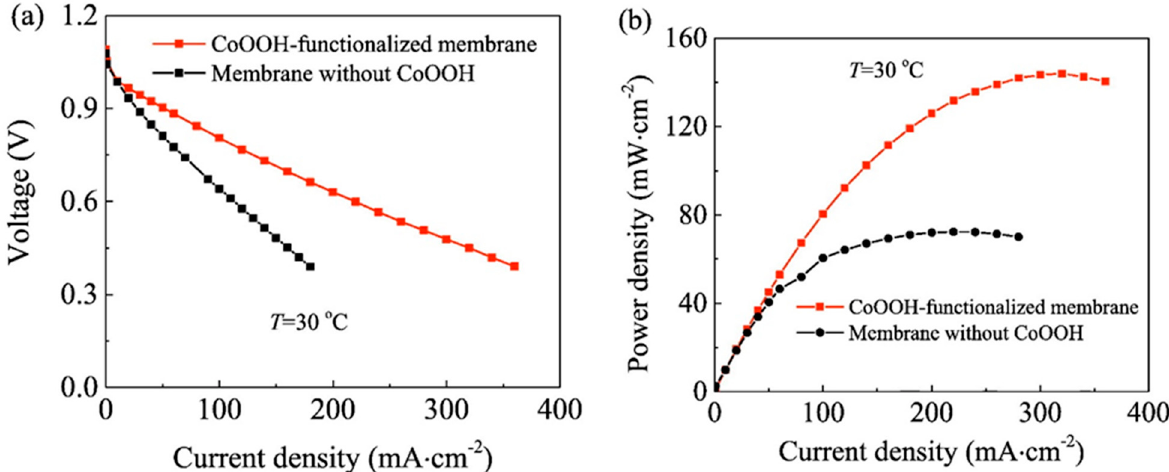
Figure 13. DBFCs performances for CoOOH − functionalized and pristine membranes. V ( a ) and power density ( b ) as a function of discharge current density at 30 °C. Reproduced with permission from Ref. [128].